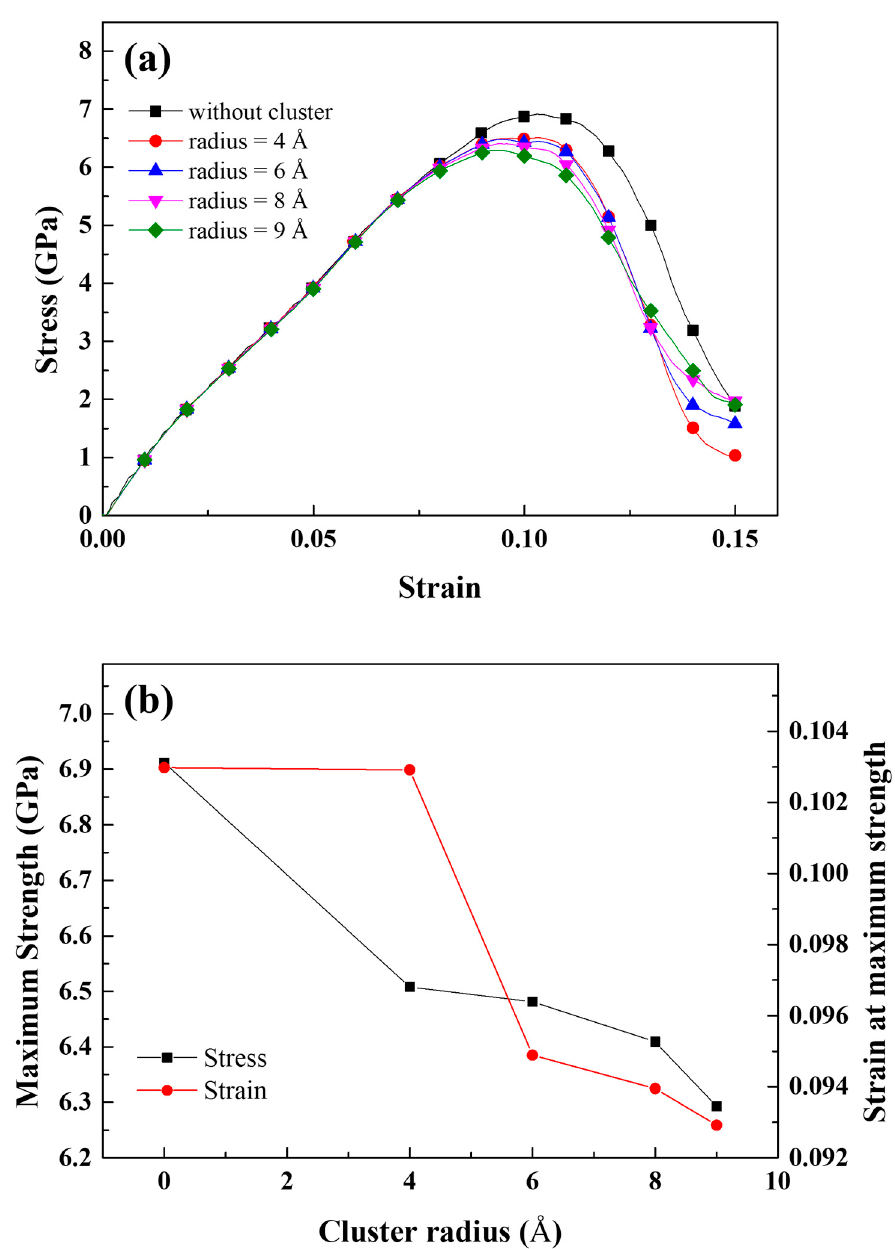
Figure 3. ( a ) Stress – strain curve of a cracked Al single crystal containing Mg – Si clusters with radii of 0, 4, 6, 8, and 9 Å. ( b ) Maximum stress and the strain at maximum stress as a function of the of 0, 4, 6, 8, and 9 Å . ( b ) Maximum stress and the strain at maximum stress as a function of the cluster cluster radius.